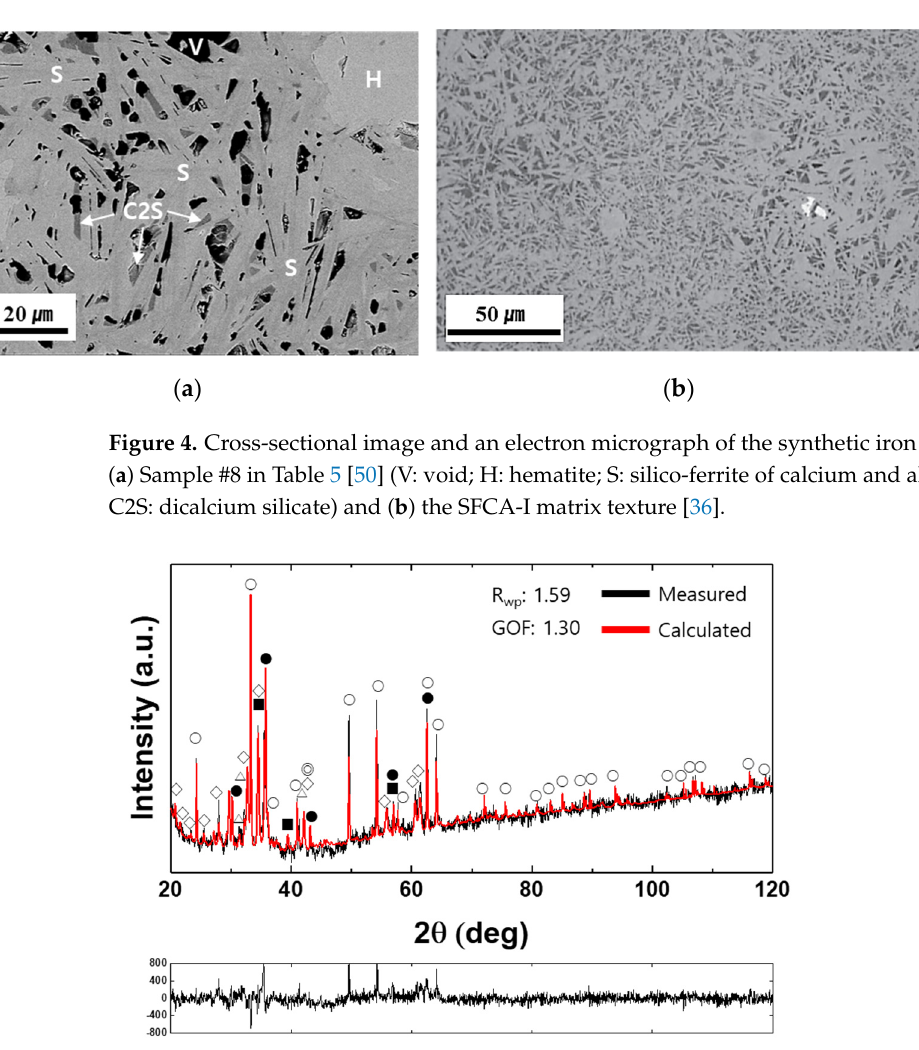
Table 5. Chemical compositions and phase fractions of iron ore sinters (wt%).